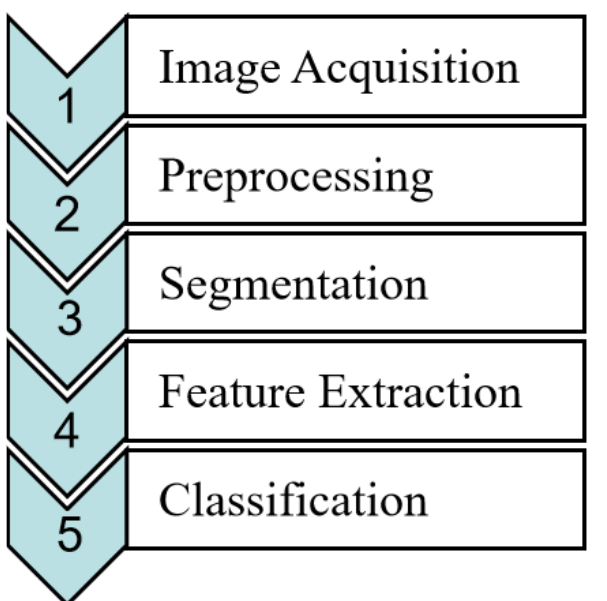
Figure 1. Methodology implemented for the recognition of the damage caused by the cogollero worm [14].